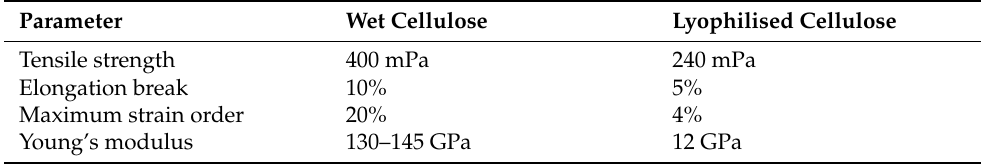
Table 1. Comparison of parameters for wet and lyophilised bacterial cellulose expanded [21–23]. Parameter Wet Cellulose Lyophilised Cellulose Tensile strength 400 mPa 240 mPa Elongation break 10% 5% Maximum strain